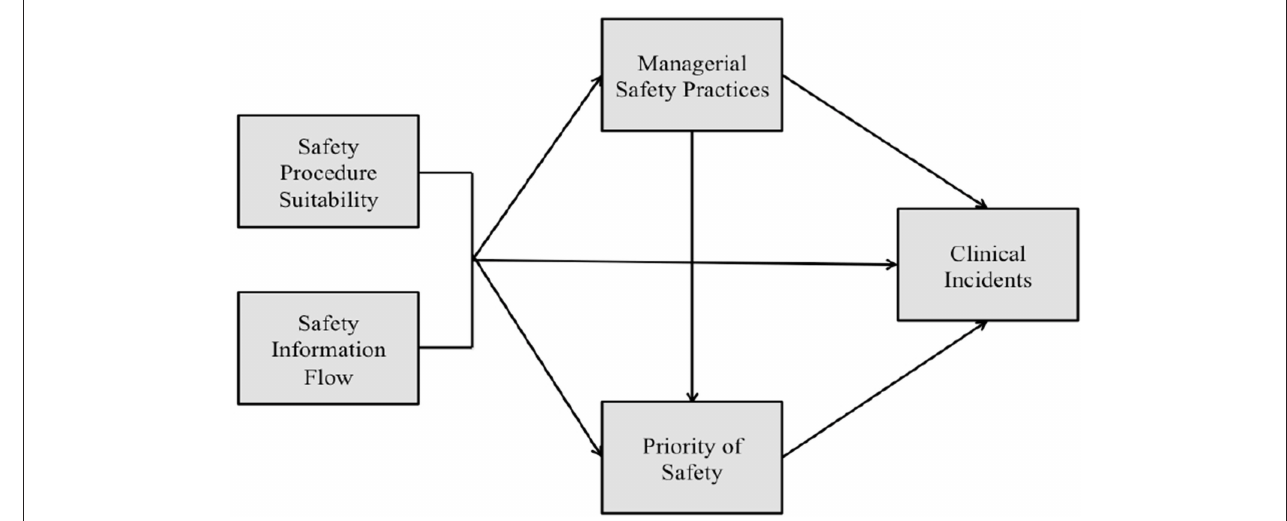
FIGURE 1 | Proposed theoretical